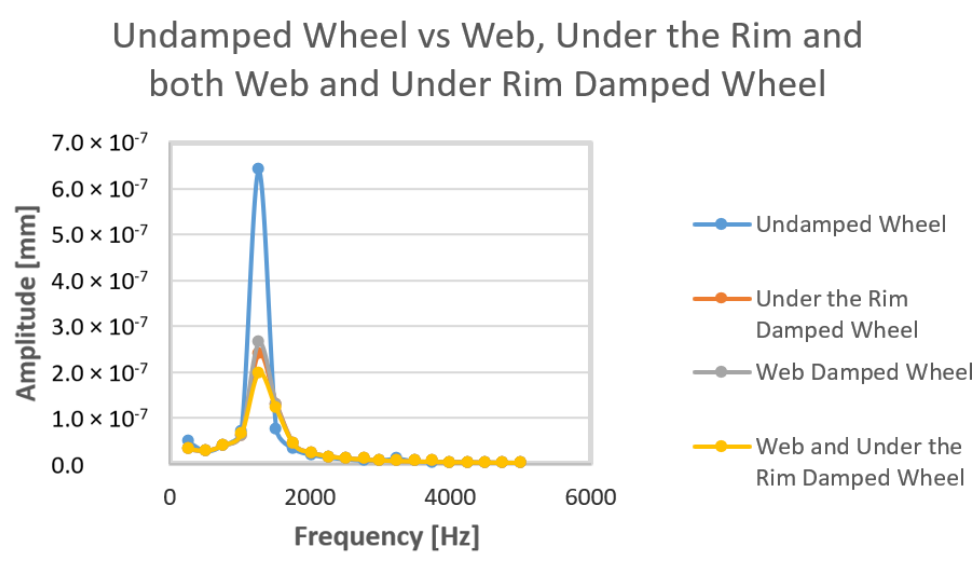
Figure 17. Comparison between the undamped and damped (all arrangements) wheels.